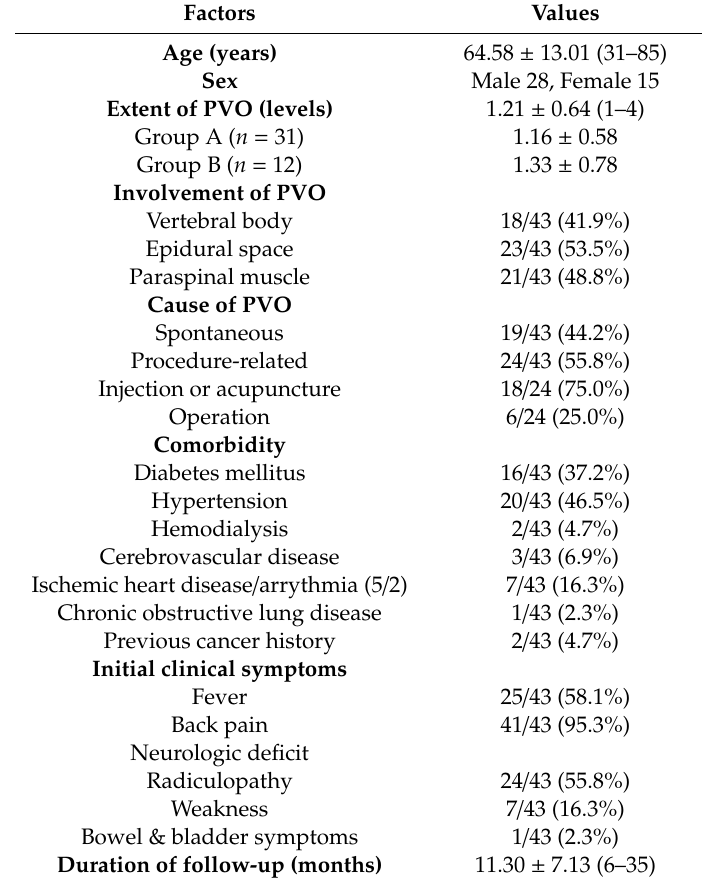
Table 1. Demographic and clinical data of 43